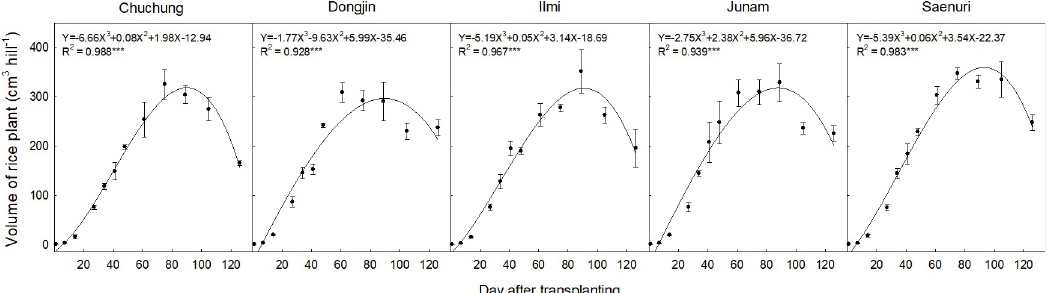
Fig 2. Changes in biomass volumes of selected rice cultivars during rice cropping